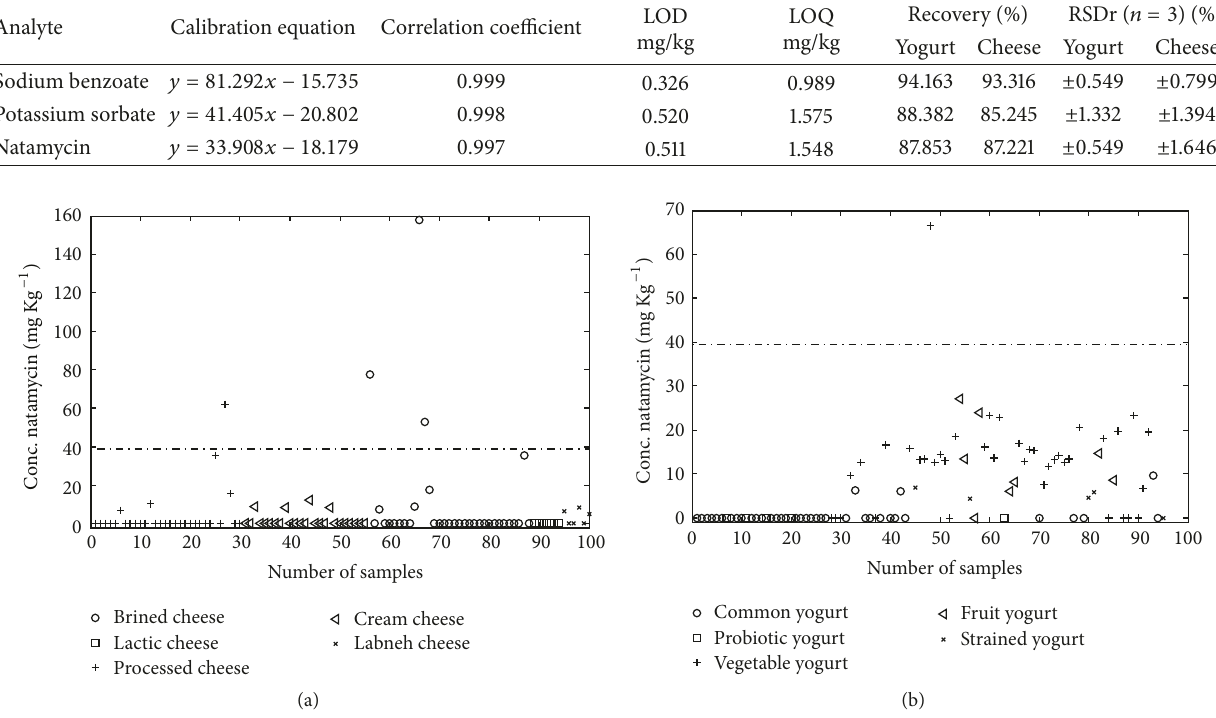
Figure 3: Illustration the natamycin content in (a) cheese and (b) yogurt